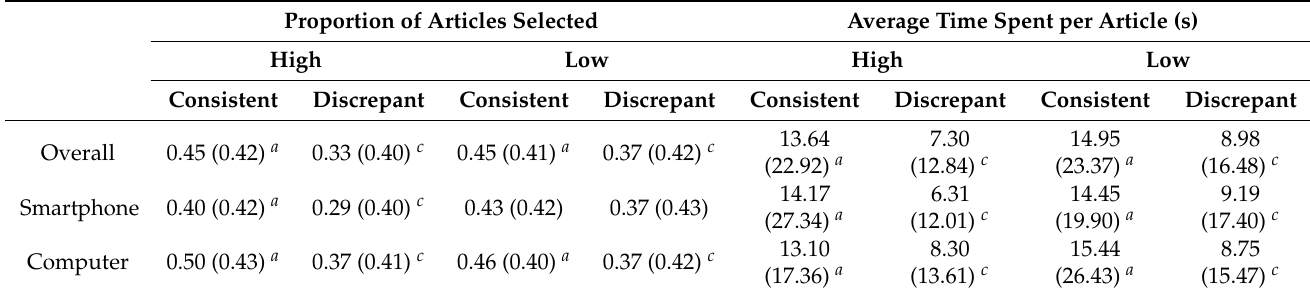
Table 6. Confirmation Bias Among Articles with High and Low Social Cues (Study 2). Proportion of Articles Selected Average Time Spent per Article (s) High Low High Low Consistent Discrepant Consistent Discrepant